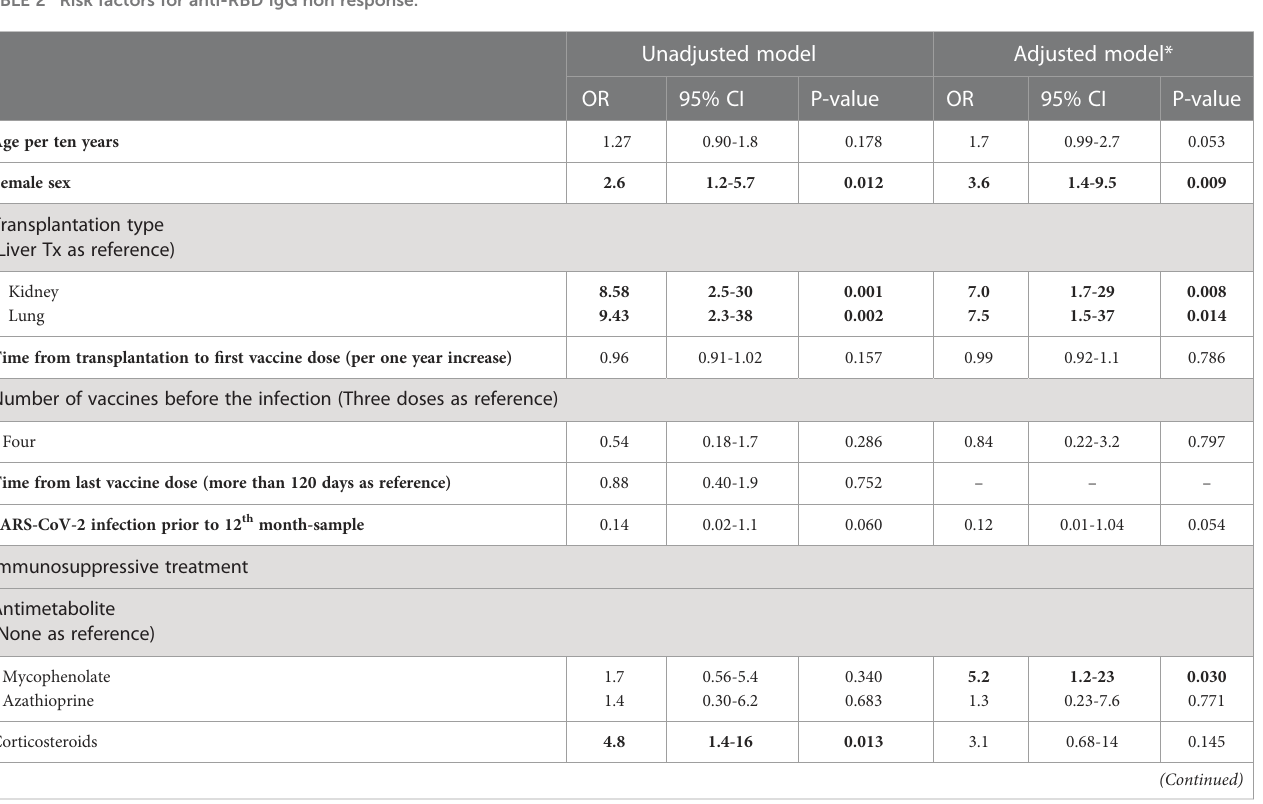
TABLE 2 Risk factors for anti-RBD IgG non